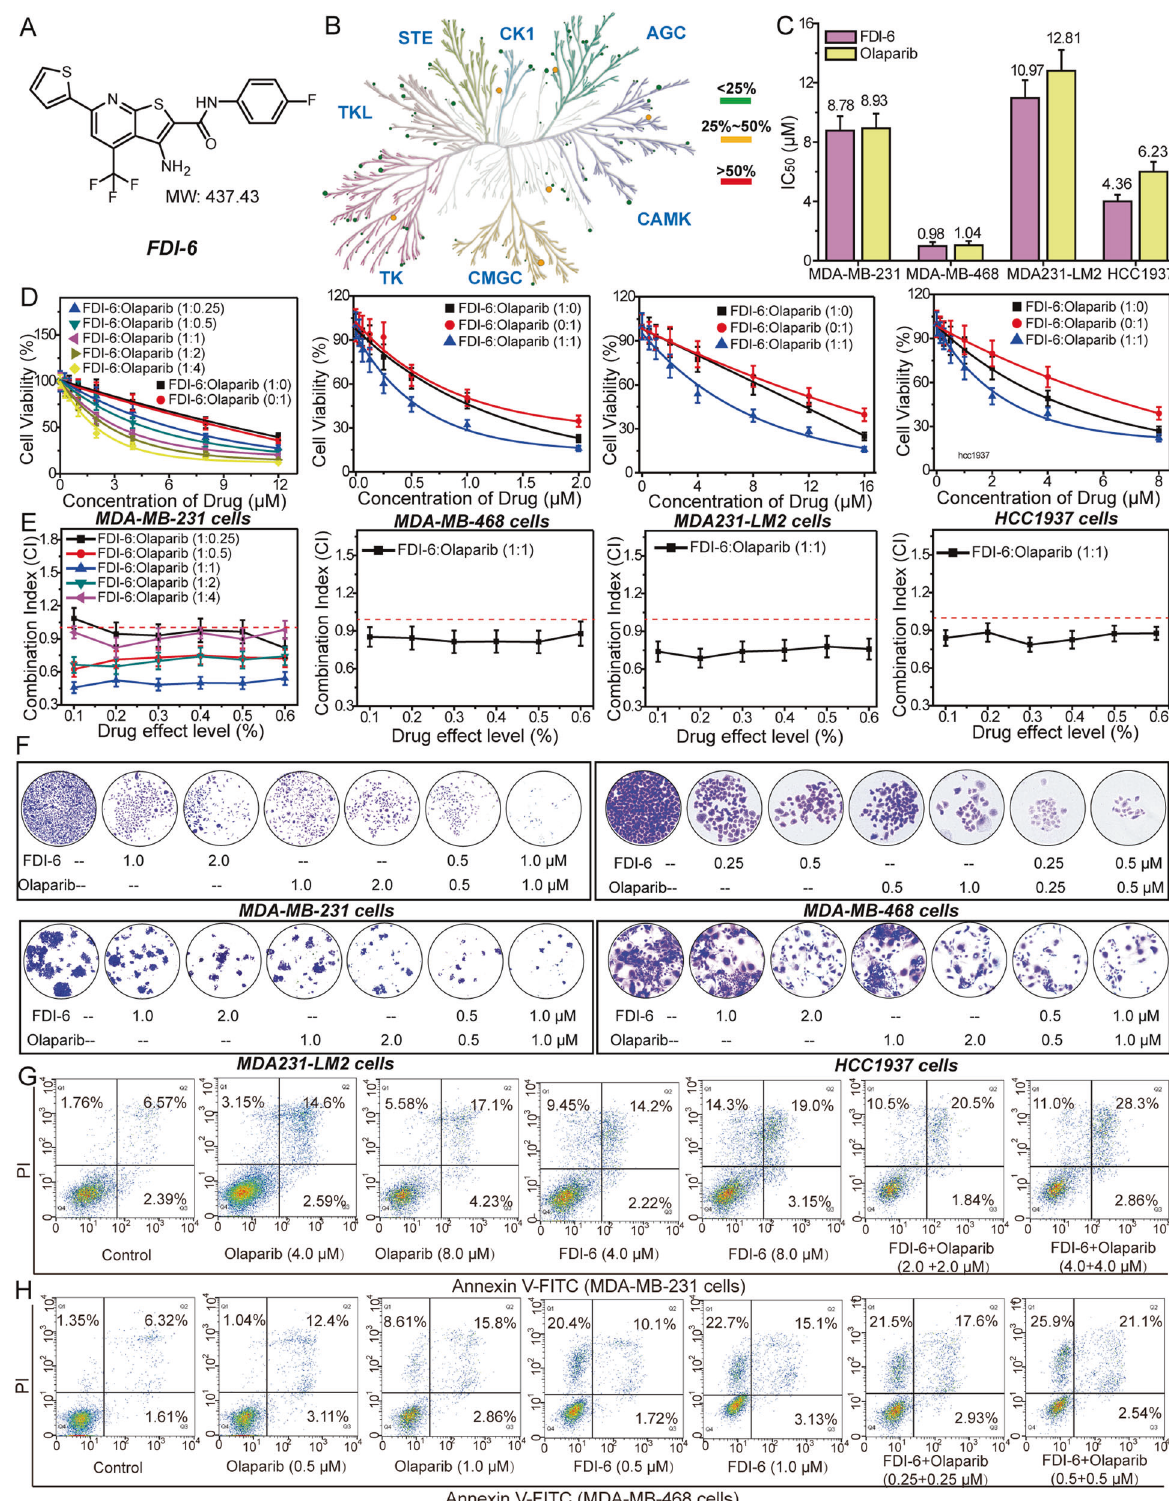
Fig. 2 FDI-6 and Olaparib synergistically inhibit the growth of TNBC cells in vitro. A The structure of FDI-6. B The kinase-selectivity pro fi le of FDI-6 using an RBC kinase panel screen against 361 kinases assayed at 1.0 μ M in duplicate. C IC 50 values for the effects of FDI-6 and Olaparib on the viability of TNBC cells. D The effects of combining FDI-6 and Olaparib on the proliferation of TNBC cells. E CI values for concurrent treatment with FDI-6 and Olaparib in TNBC cells. The combination ratios of FDI-6/Olaparib are 1:0.25, 1:0.5, 1:1, 1:2, and 1:4. F The effects of FDI-6 and/or Olaparib on the proliferation of TNBC cells measured by colony-forming assay. The effects of FDI-6 and/or Olaparib on the apoptosis of MDA-MB-231 cells ( G ) and MDA-MB-468 cells ( H ).